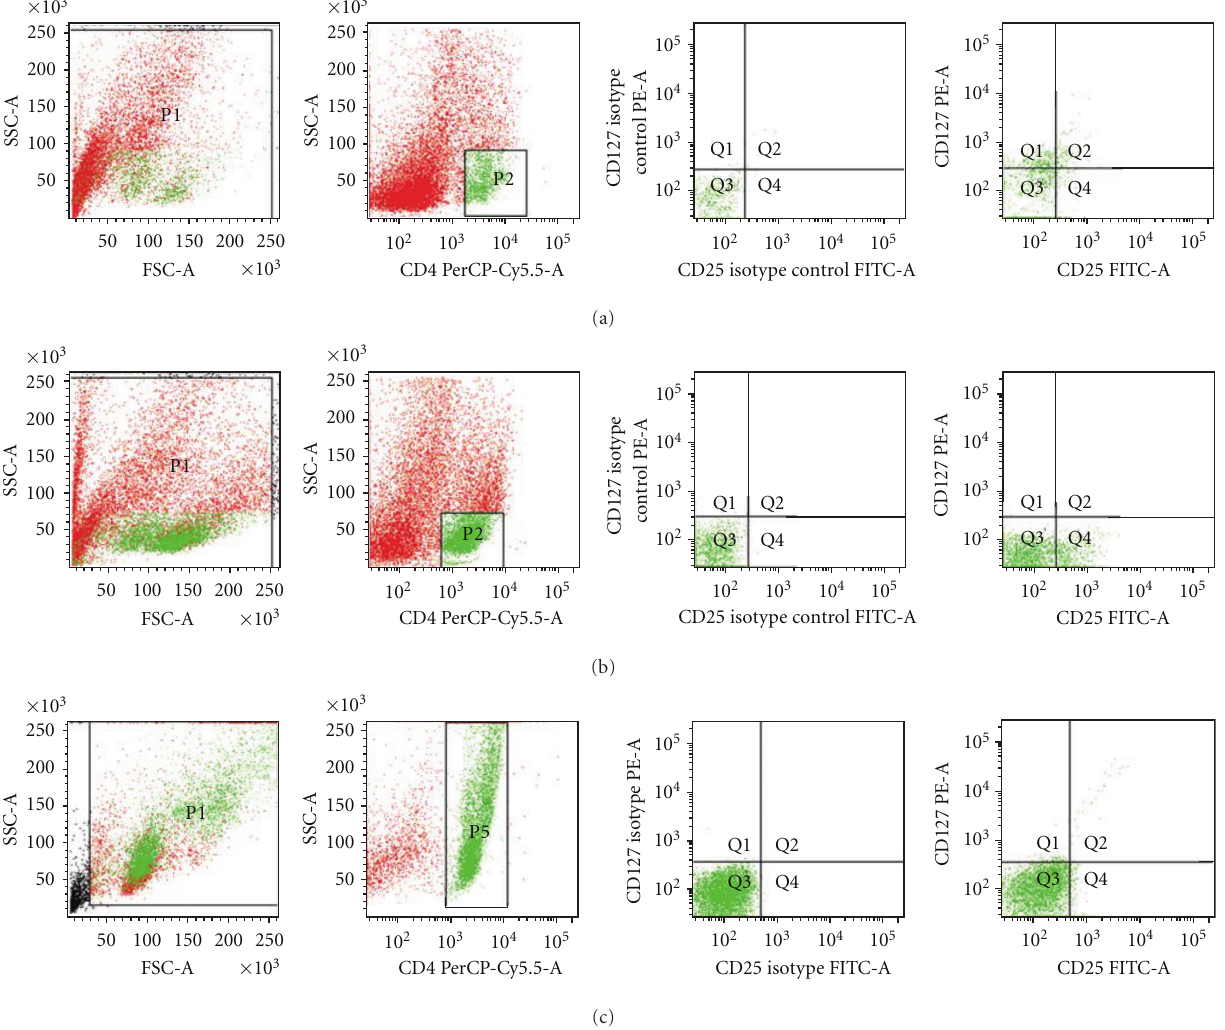
Figure 3: The proportion and absolute number of CD4 + CD25 + CD127 − Tregs in CD3 + T cells increased after coculture with IDO/CHO cells. CD3 + T cells isolated from PBMCs of breast cancer patients were cocultured with CHO/IDO or CHO/EGFP cells for 7 days to allow induction of Tregs. The proportions and absolute number of CD4 + CD25 + CD127 − Tregs were detected by flow cytometry. (a) The proportion of CD4 + CD25 + CD127 − Tregs in the T cells treated with IDO − CHO/EGFP cells (P2 region represents CD4 + T cells; Q4 region represents CD4 + CD25 + CD127 − Tregs). (b) The proportion of CD4 + CD25 + CD127 − Tregs in the T cells treated with IDO + CHO/IDO cells (P2 region represents CD4 + T cells; Q4 region represents CD4 + CD25 + CD127 − Tregs). (c) The CD3 + control T cells (P5 region represents CD4 + T cells; Q4 region represents CD4 + CD25 + CD127 − Tregs). The flow cytometry dot plots indicate data of one representative experiment. Each experiment was repeated at least 3